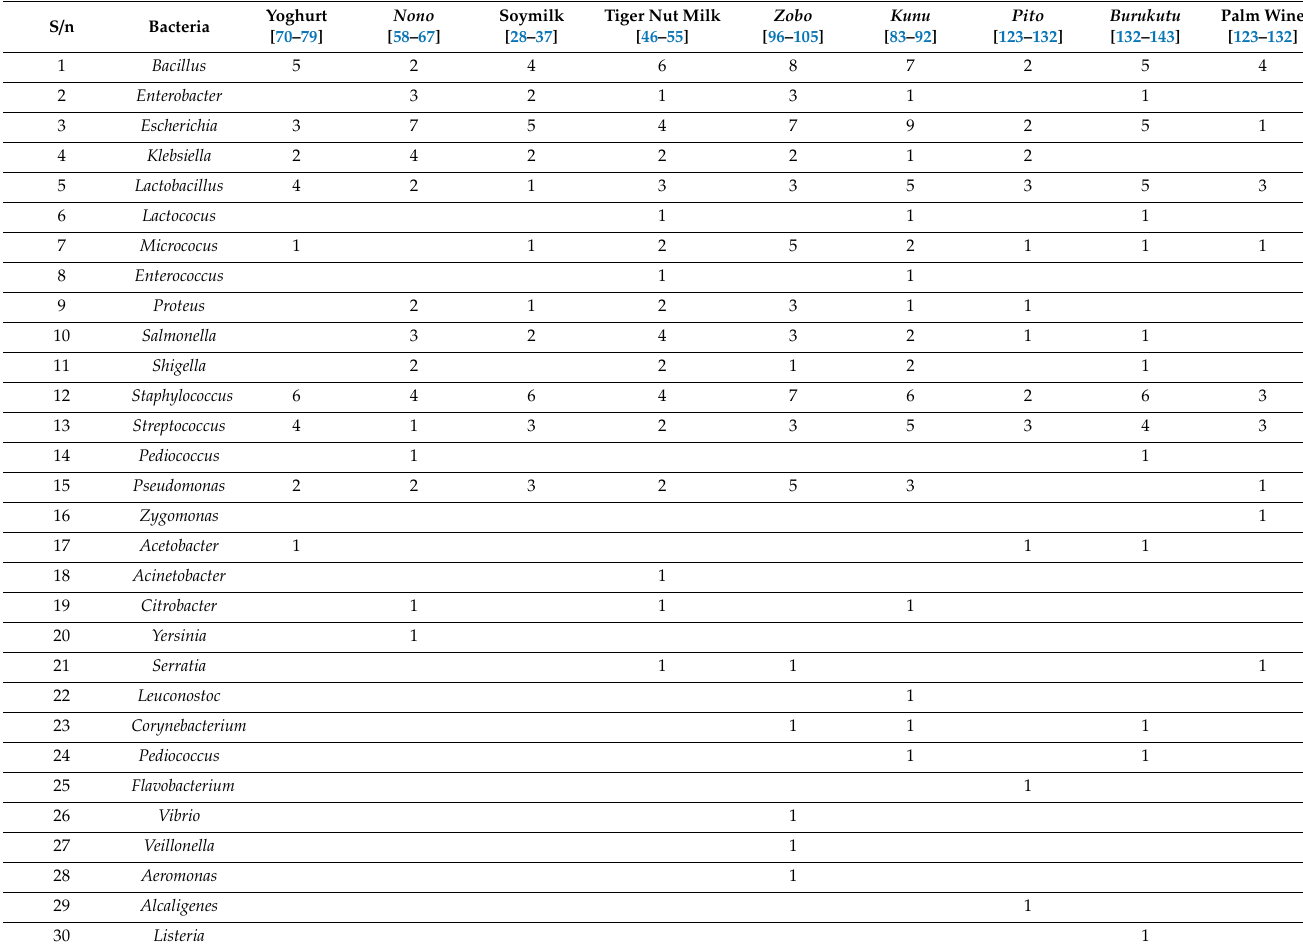
Table 1. Summary of the prevalence of bacteria and fungi in Nigerian beverages after an analysis of up to 90 studies. The prevalence was calculated by recording the number of times a particular genus was reported in a